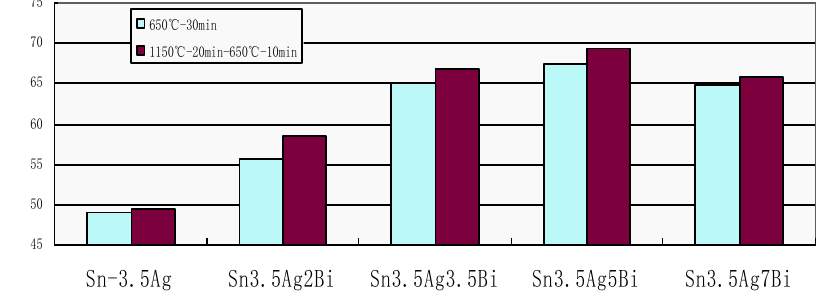
Figure 22. The effect of melt state on the shear strength (MPa) of Sn-3.5Ag- x Bi/Cu joint